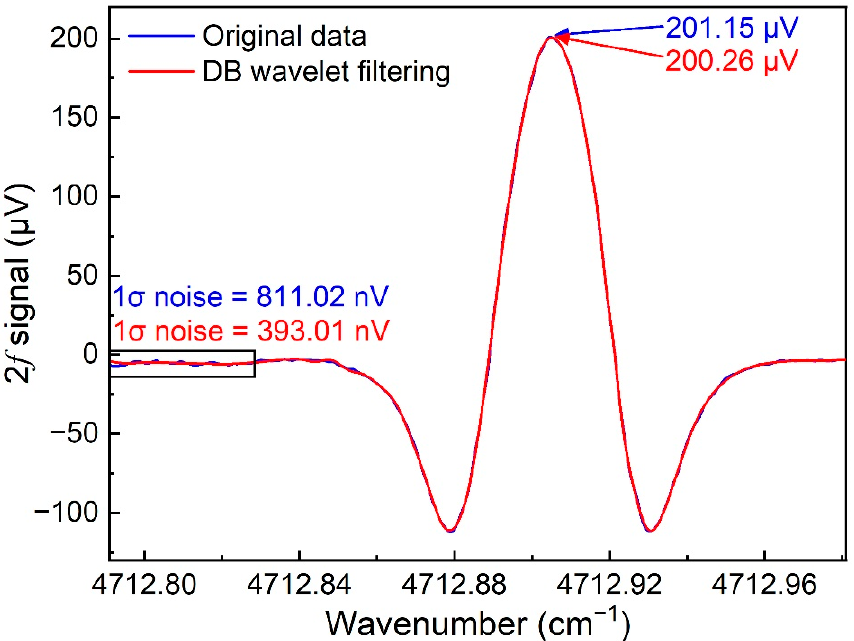
Figure 8. H 2 -TDLAS 2 f signal comparison with and without the DB wavelet denoising when H 2 concentration is 100%.